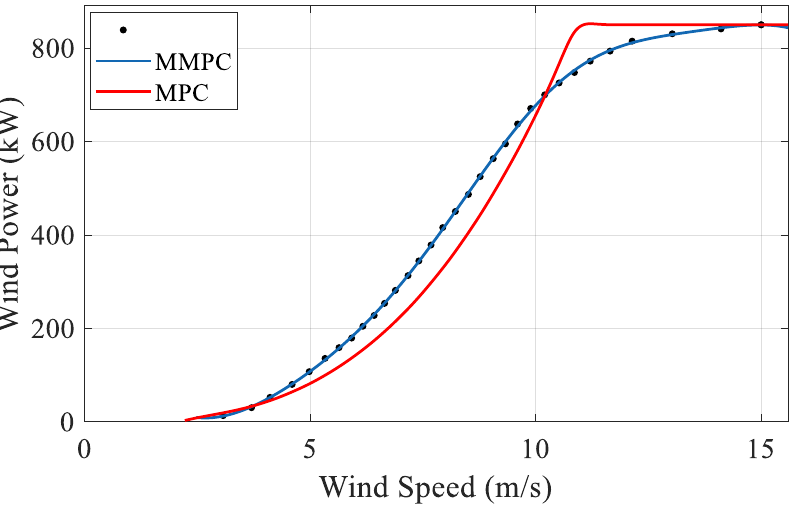
Figure 10. Wind speed-power curve fitting result.